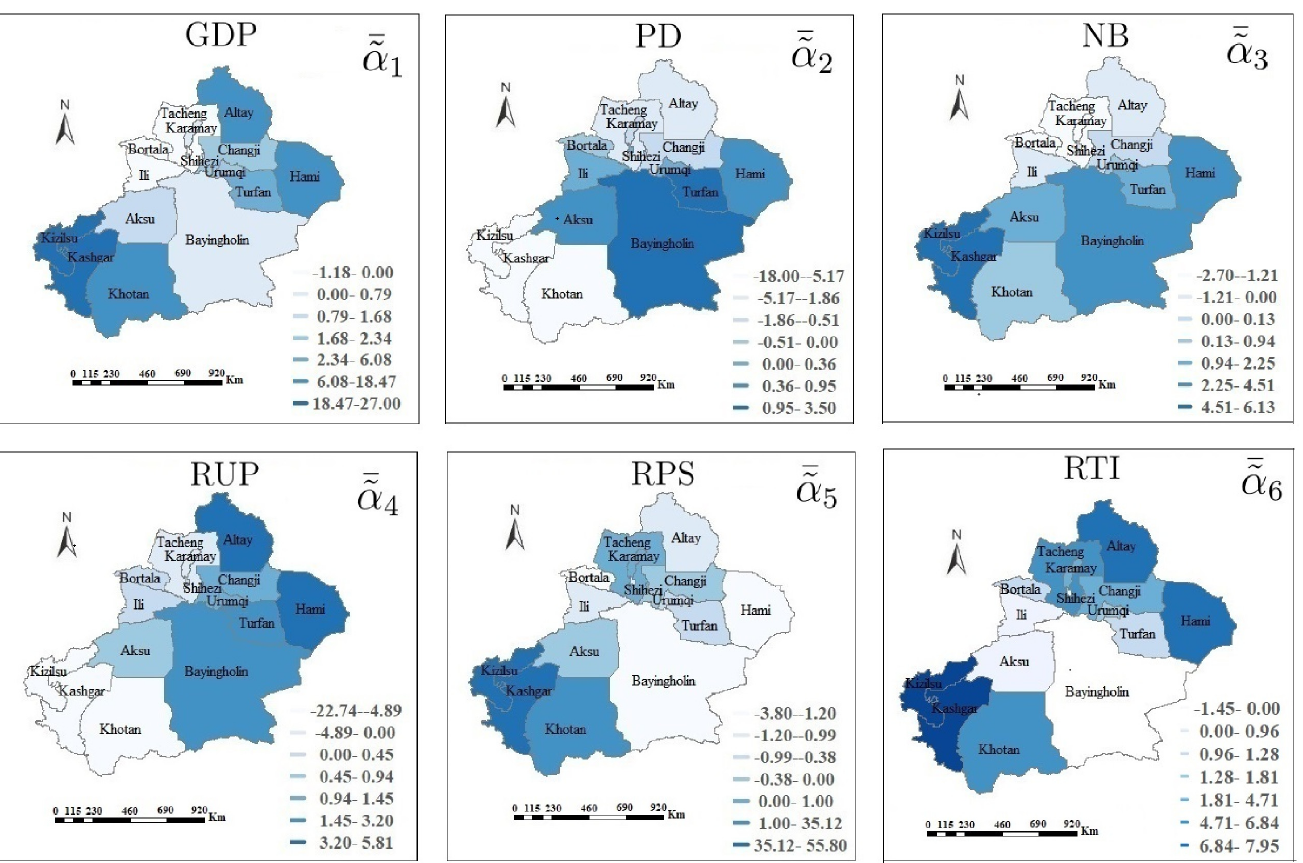
Fig 10. The average coefficient estimations for six socioeconomic factors. It is generated by software ArcGIS 10.2 from http://eol.jsc.nasa.gov/SearchPhotos/.